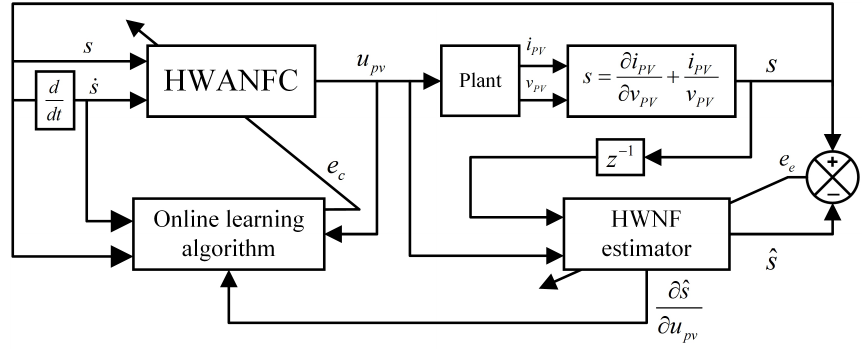
Figure 2. Adaptive Hermite Wavelet-based Adaptive Neural Fuzzy Controller (HWANFC) control